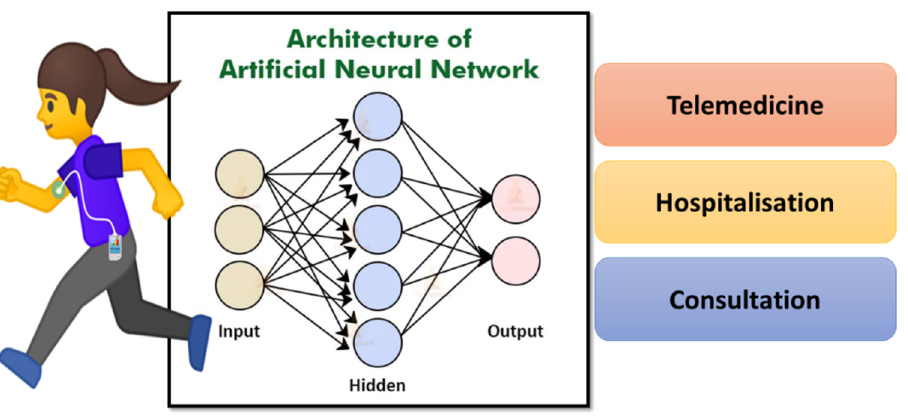
Figure 11. Representation of artificial neural network using patient data to identify the correct treatment plan.